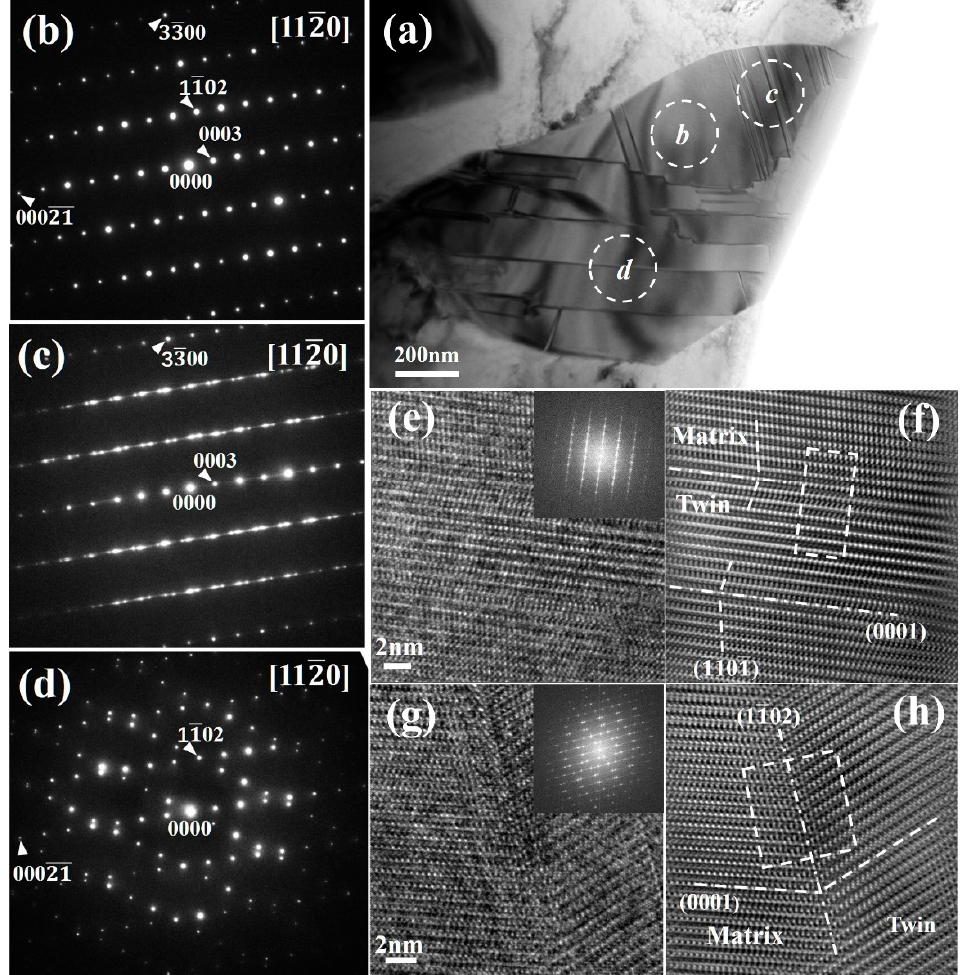
Figure 3. ( a ) A bright-field TEM image of the µ phase with twins contrast; ( b – d ) corresponding SAED patterns from the circled regions “ b ”, “ c ”, and “ d ” in ( a ), respectively; ( e ) and ( g ) high-resolution TEM images of (0001) µ and (1102) µ twins along [1120] µ ZA, and the corresponding FFT patterns are displayed in the upper right corner, whereas ( f ) and ( h ) present the inverse FFT lattice images of ( e ) and ( g ), respectively.